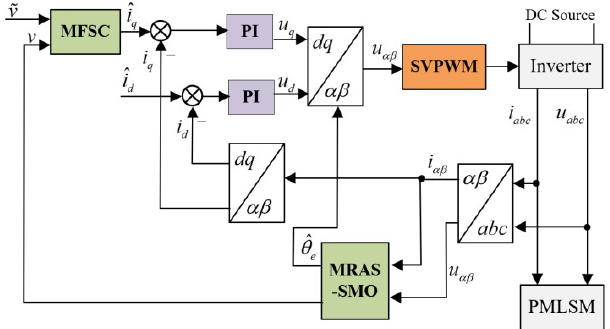
Figure 5. Establishment of the PMLSM